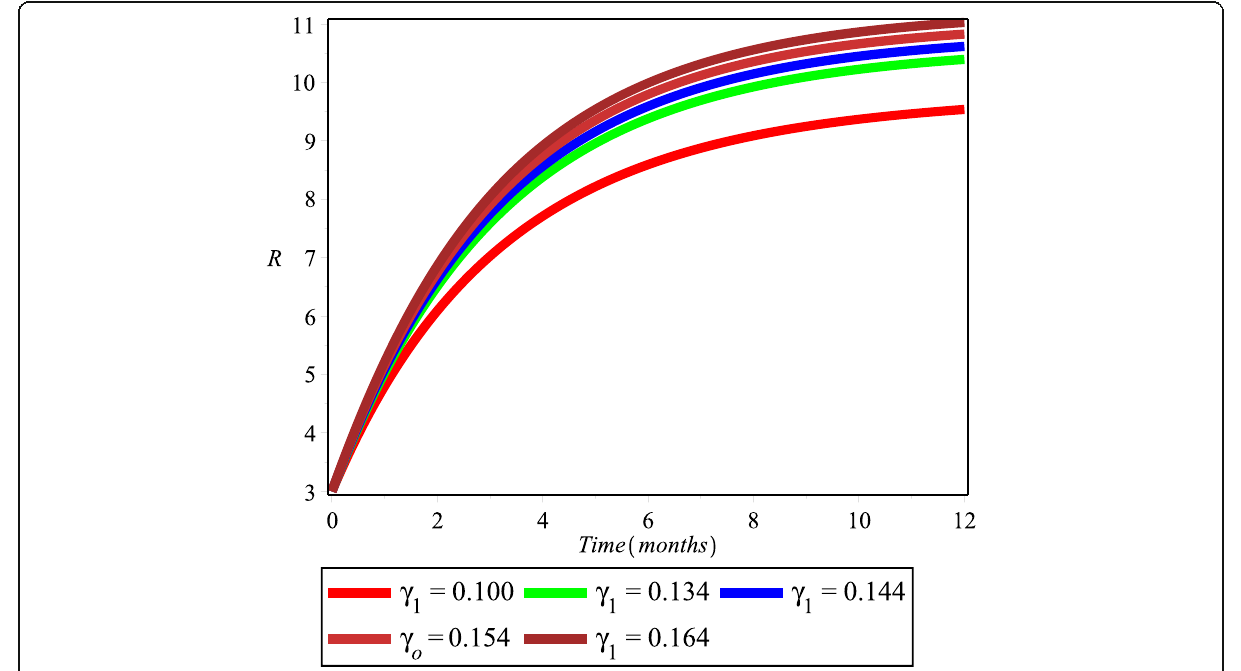
Fig. 7 Varying β (0.710 − 0.960) when R r >